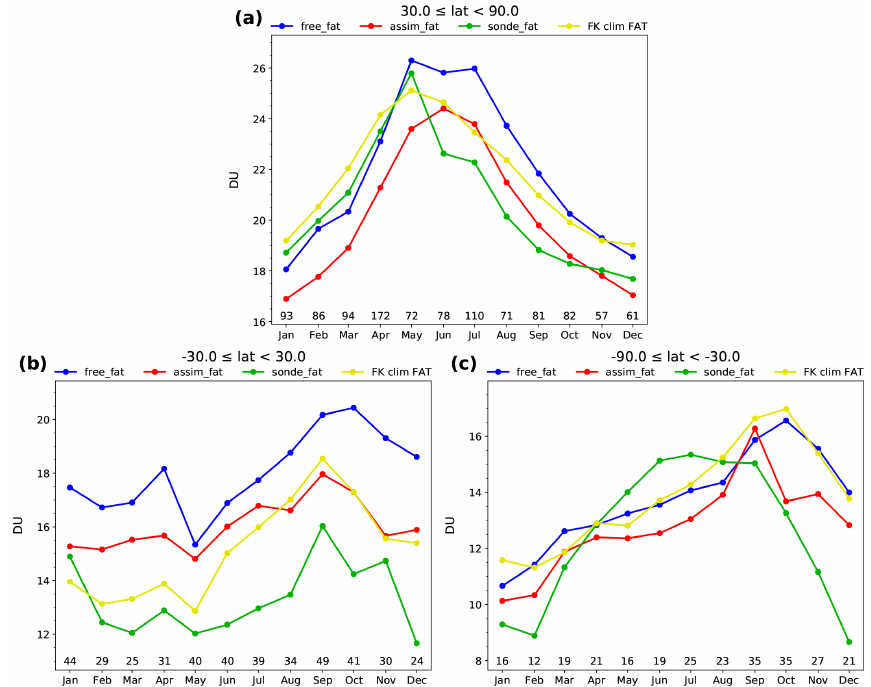
Figure 7. Time series of monthly median global FAT columns for (a) the Southern Hemisphere ( − 90 ≤ lat < − 30), (b) the tropics ( − 30 ≤ lat < 30) and (c) the Northern Hemisphere (lat ≥ 30). Blue line: free model run; red line: assimilated O 3 fields; green line: sonde data; yellow line: Fortuin and Kelder climatology. The numbers along the x axis indicate the number of collocations between model and sondes. Note the different scale on the y axis in each